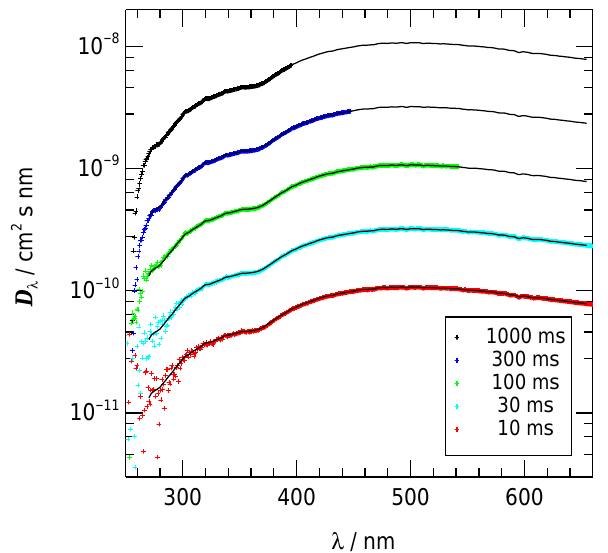
Figure 8. Spectral sensitivities of instrument 62001 at different in- tegration times. Full lines show an optimized sensitivity that was scaled dependent on integration time according to Eq. (13). Data points show the separately measured sensitivities for comparison.